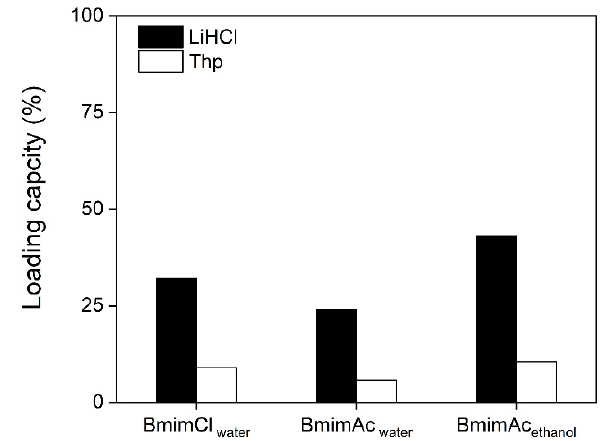
Figure 3. Loading capacities of cellulose beads prepared from waste denim.